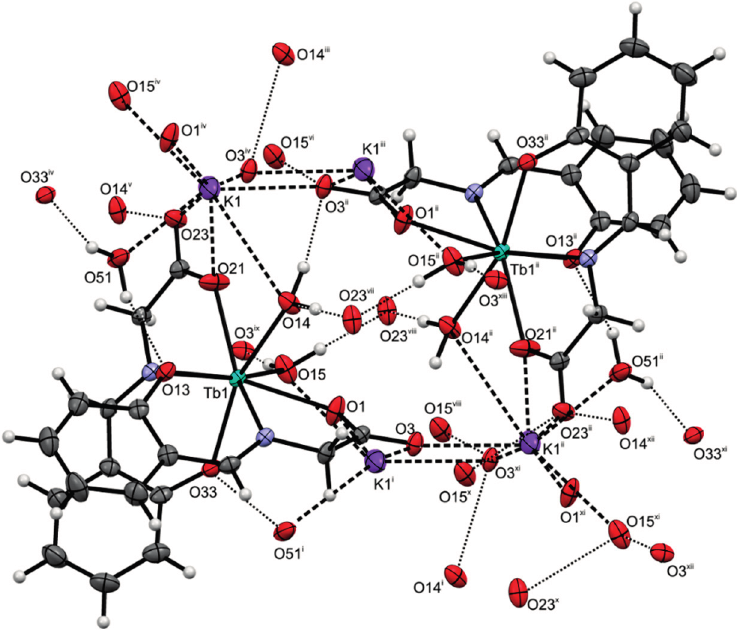
Figure 2. A part of crystal structure of complex 2 , showing variety of O–H ··· O hydrogen bonds (dotted lines) and electrostatic non-bonding K ··· O interactions (dashed lines).